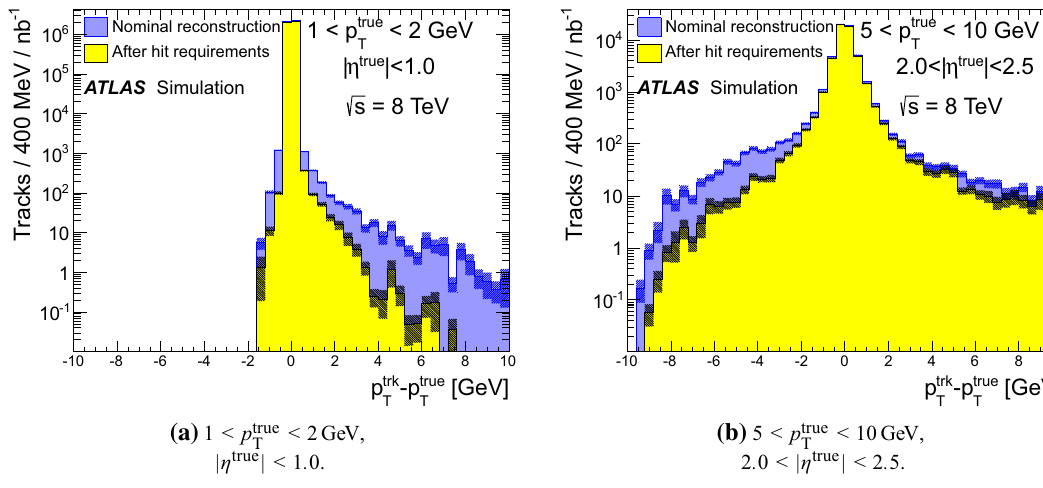
Fig. 9 The difference between the reconstructed p T of the track from a charged pion and the particle’s true p T for two bins in truth particle p T and | η | , determined in dijet MC simulation with similar pile-up to that in the 2012 data. The shaded bands represent the statistical uncertainty. The tails in the residuals are substantially diminished upon the applica-